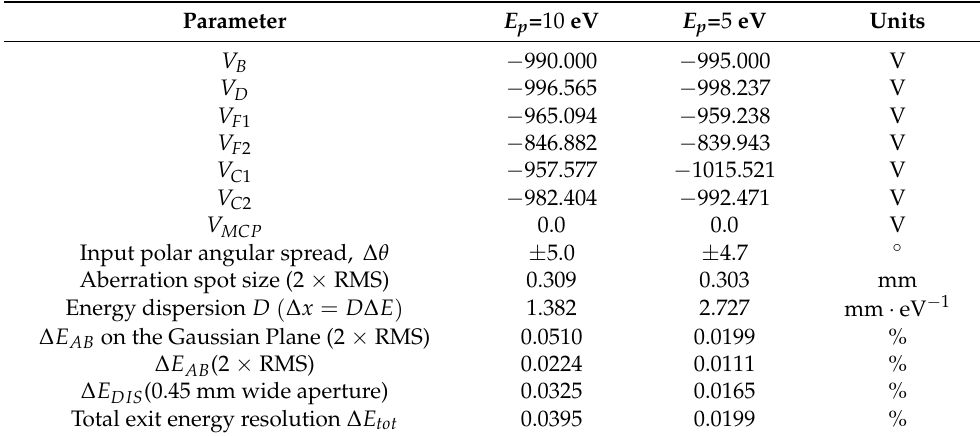
Table 1. Simulated energy resolution and energy dispersion characteristics of the optimized analyzer attachment design for 1 keV incoming BSEs retarded down to the pass energies of 10 eV and 5 eV. All focusing/dispersion parameters, unless otherwise stated, are evaluated on the exit aperture plane. Parameter E p = 10 eV E p = 5 eV Units V B − 990.000 −